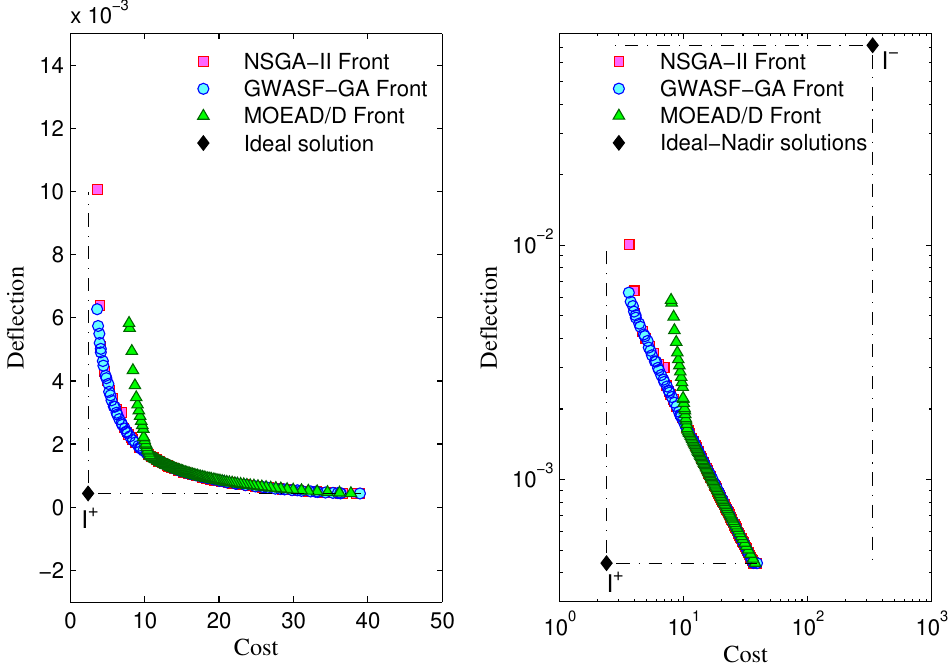
Figure 13. Approximate POF with the hypervolume indicator closest to the average value of hypervolume after 100 runs ( left ); and the same data drawn with logarithmic scale ( right ) for NSGA-II, GWASF-GA and MOEA/D ( N =